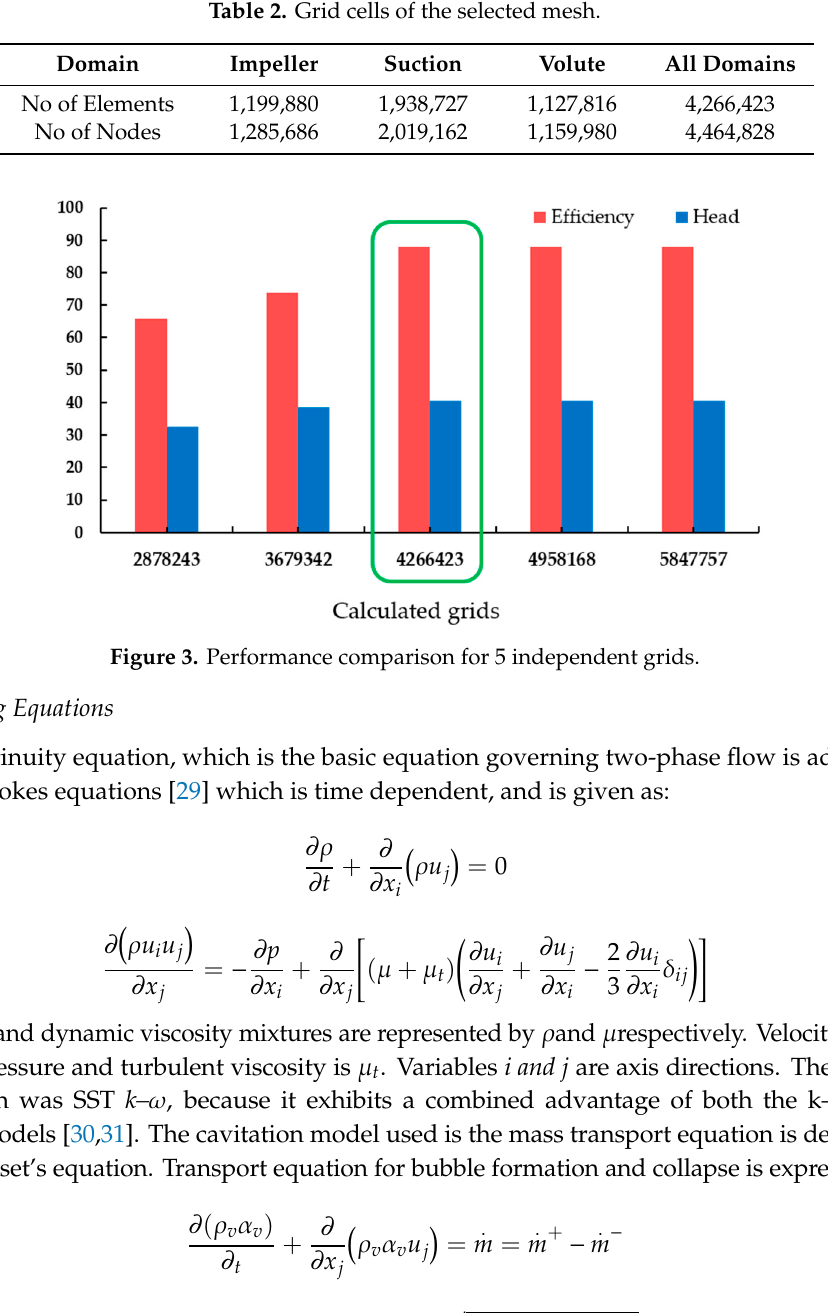
Table 2. Grid cells of the selected mesh.